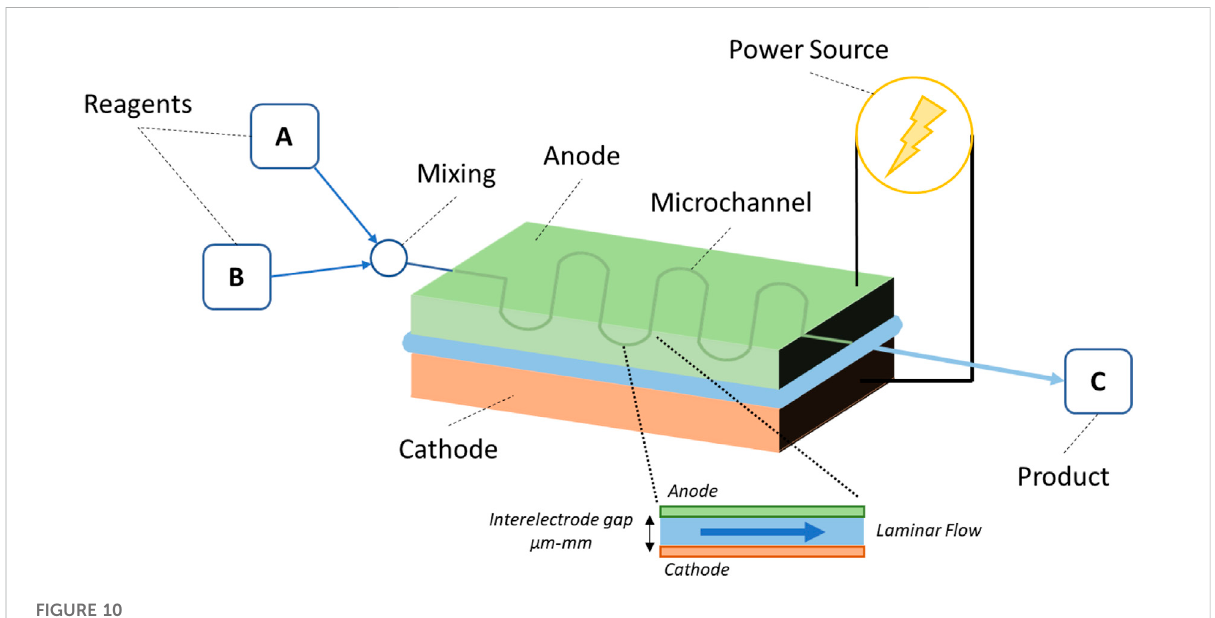
FIGURE 10 Electrochemical fl ow